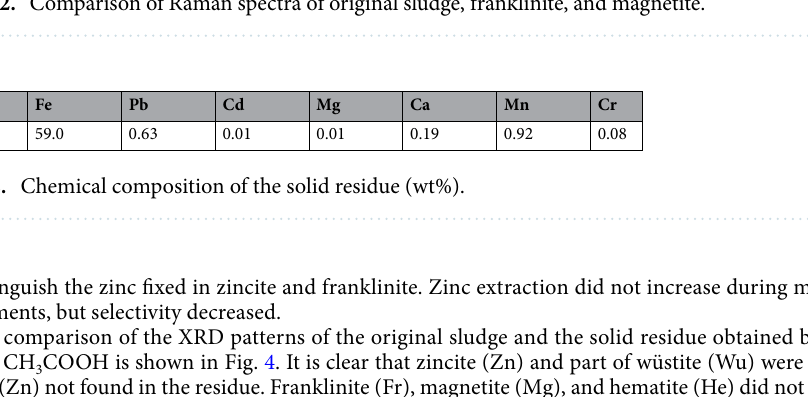
Figure 2. Comparison of Raman spectra of original sludge, franklinite, and magnetite.